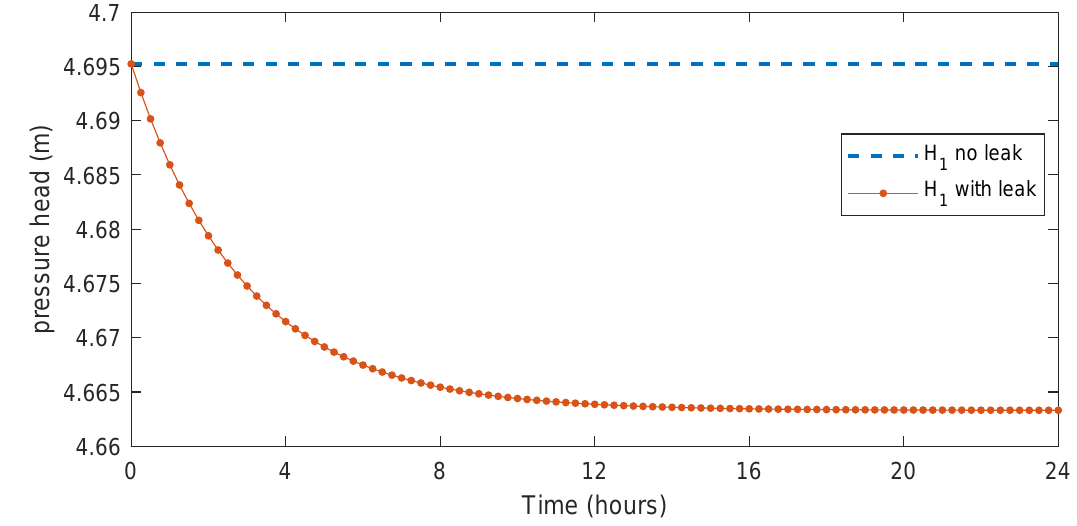
Figure 9. Pressure head loss at the pump outlet caused by a